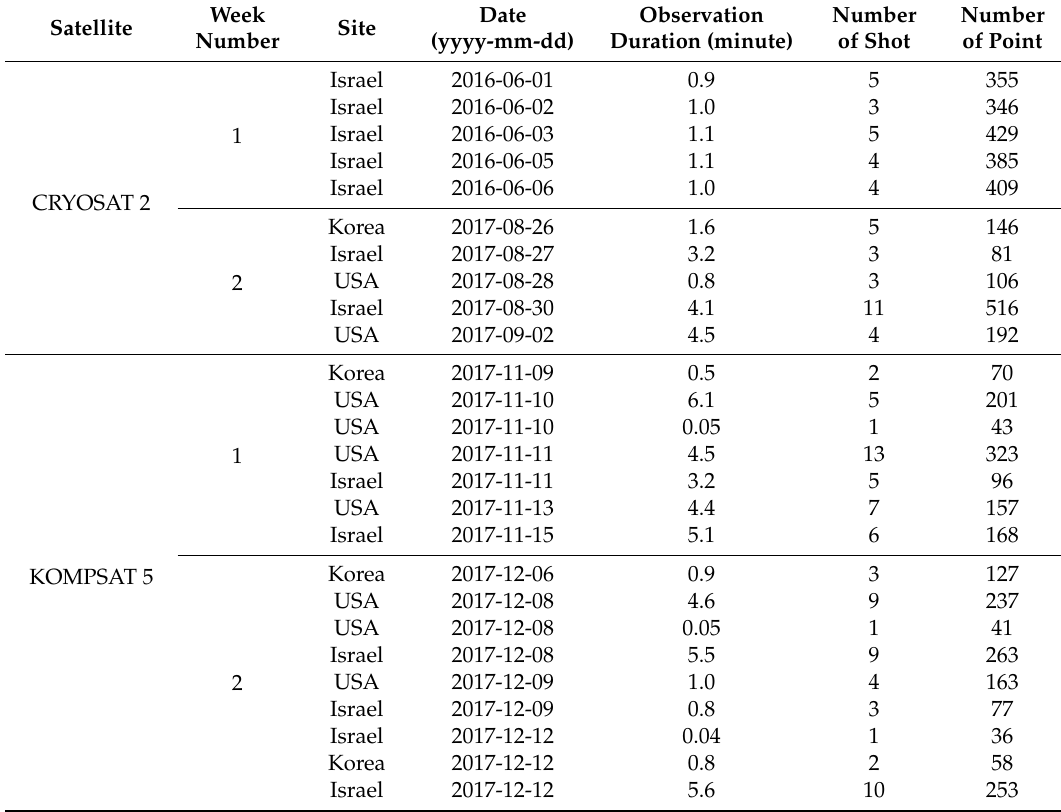
Table 2. Summary of optical observation results for validating astrometric angular accuracy. The week number was used to separate the observation data by week for orbit determination. The observation duration and number of shots were counted for the successfully achieved optical